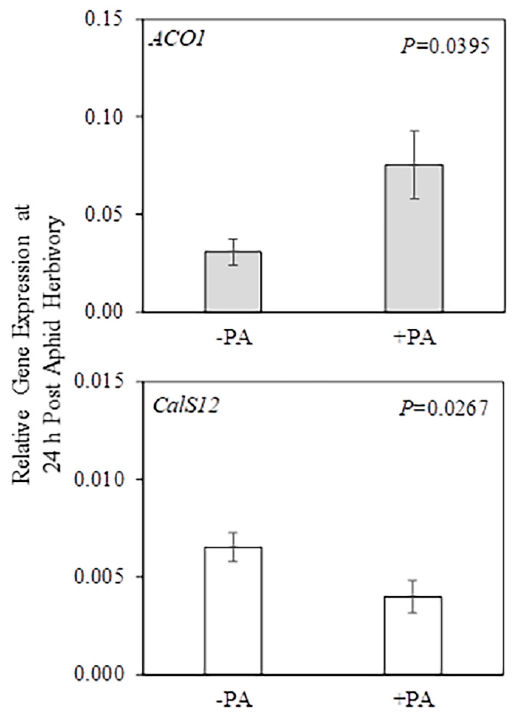
figure. ACO1 = AMINOCYCLOPROPANE-1-CARBOXYLATE OXIDASE 1; AOC = ALLENE OXIDE CYCLASE; CalS12 = CALLOSE SYNTHASE 12; ERF1 = ETHYLENE RESPONSE FACTOR 1; ETR1 = ETHYLENE RECEPTOR 1; GA20ox = GIBBERELIC ACID 20-OXIDASE; MYC2 = BASIC-HELIX-LOOP- HELIX TRANSCRIPTION FACTOR; PAL = PHENYLALANINE AMMONIA LYASE; PI-I = POTATO TYPE I PROTEASE INHIBITOR; PI-II = POTATO TYPE II PROTEASE INHIBITOR .